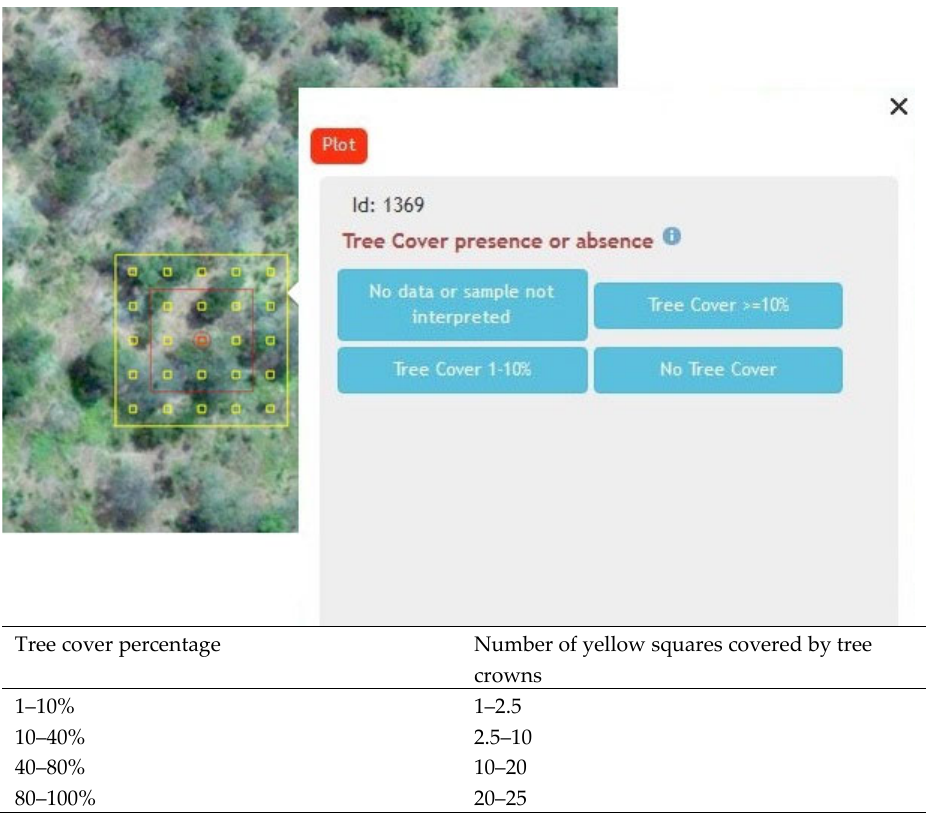
Figure 5. The 50 m by 50 m square plot interpreted in Collect Earth and the interpretation rules. Maps data: Google, © 2021 Maxar Technologies.